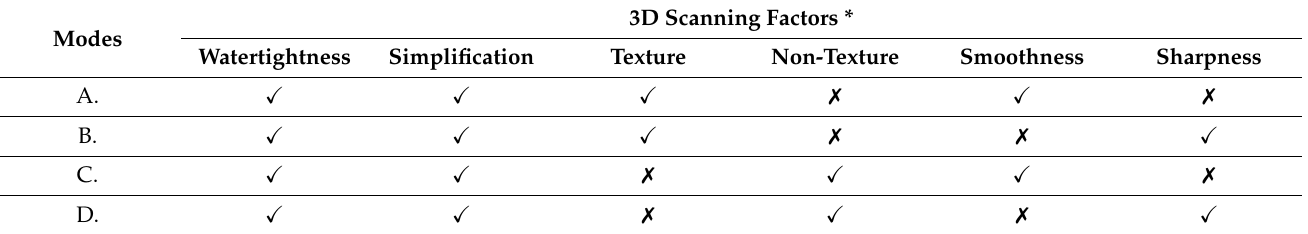
Table 2. Modes of 3D